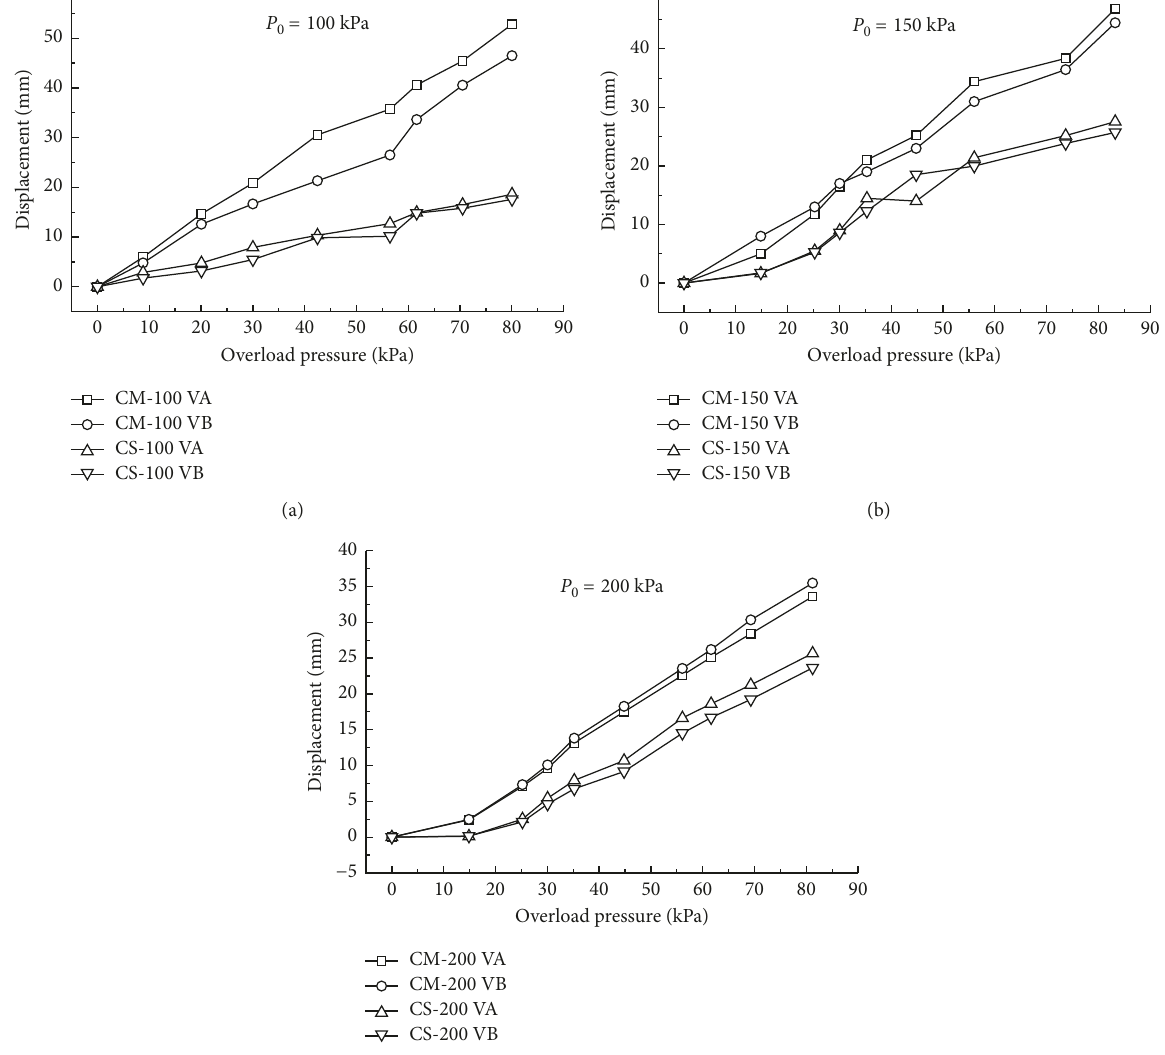
� 100kPa, (b) initial pressure P 0